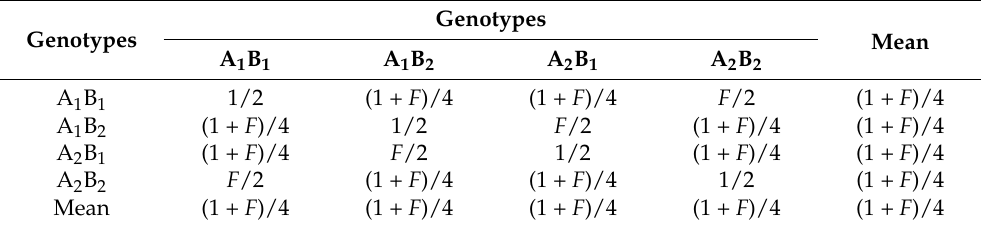
Table 1. Average inbreeding coefficients of progenies produced by random mating of a group of 4 plants whose genotypes are those generated by the single-cross A 1 A 2 × B 1 B 2 , (Equation (1)). The inbreeding coefficient of the lines is F and they are